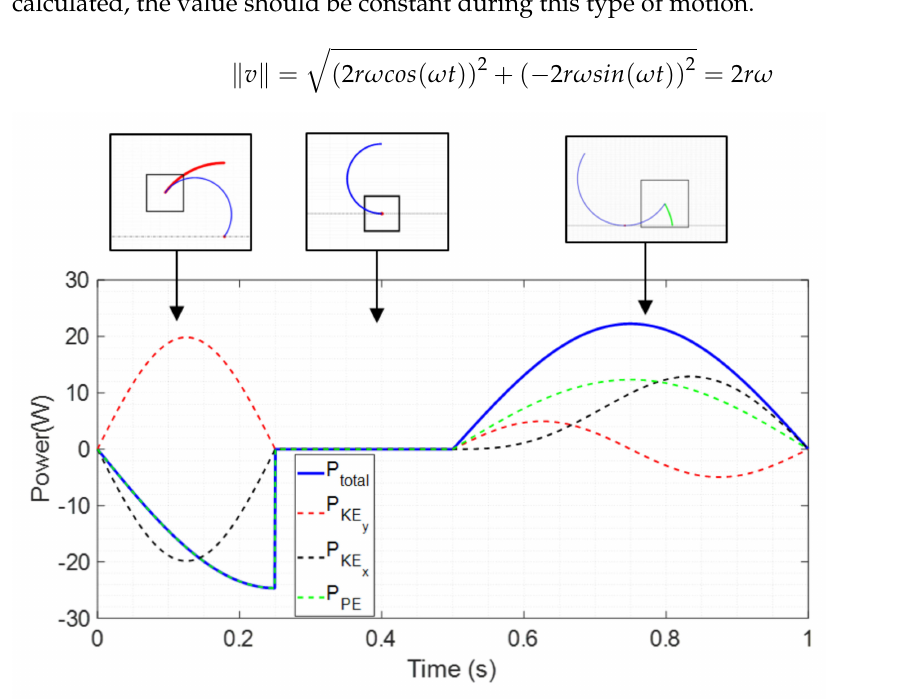
Figure 11. Total power demand for a single-leg system with r = 0.2, m = 1 kg and w = 60